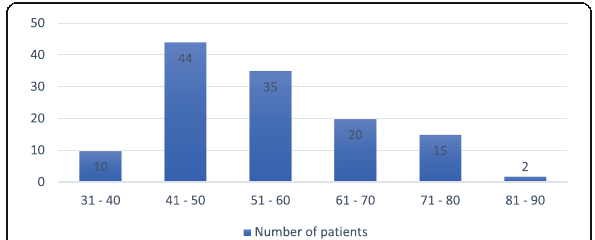
Fig. 1 Showing the age distribution of the patients in the